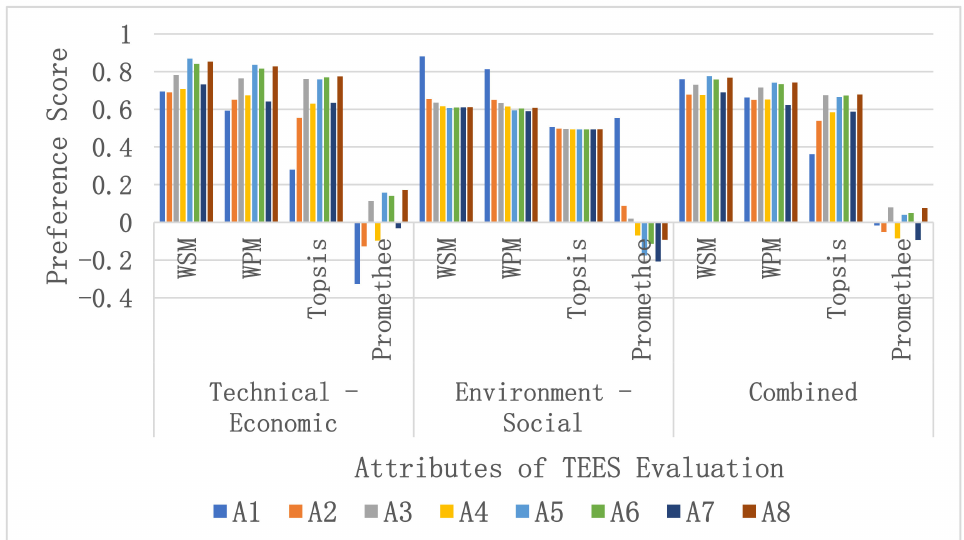
Figure 17. Attributes of TEES evaluation for Case 2e with DGs + DS OLG2 at 0.9 PF.